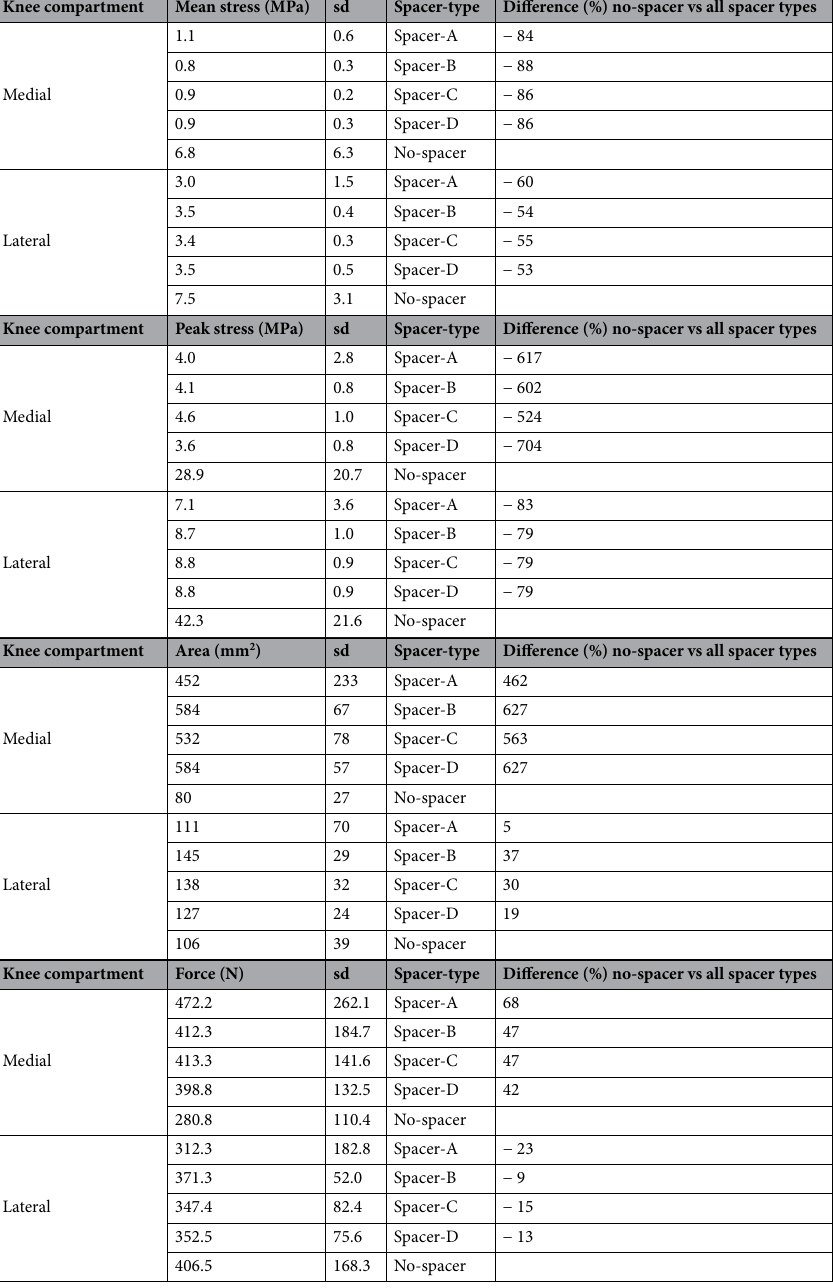
Table 1. Discrete stress, area and force parameters, mean and standard deviation are